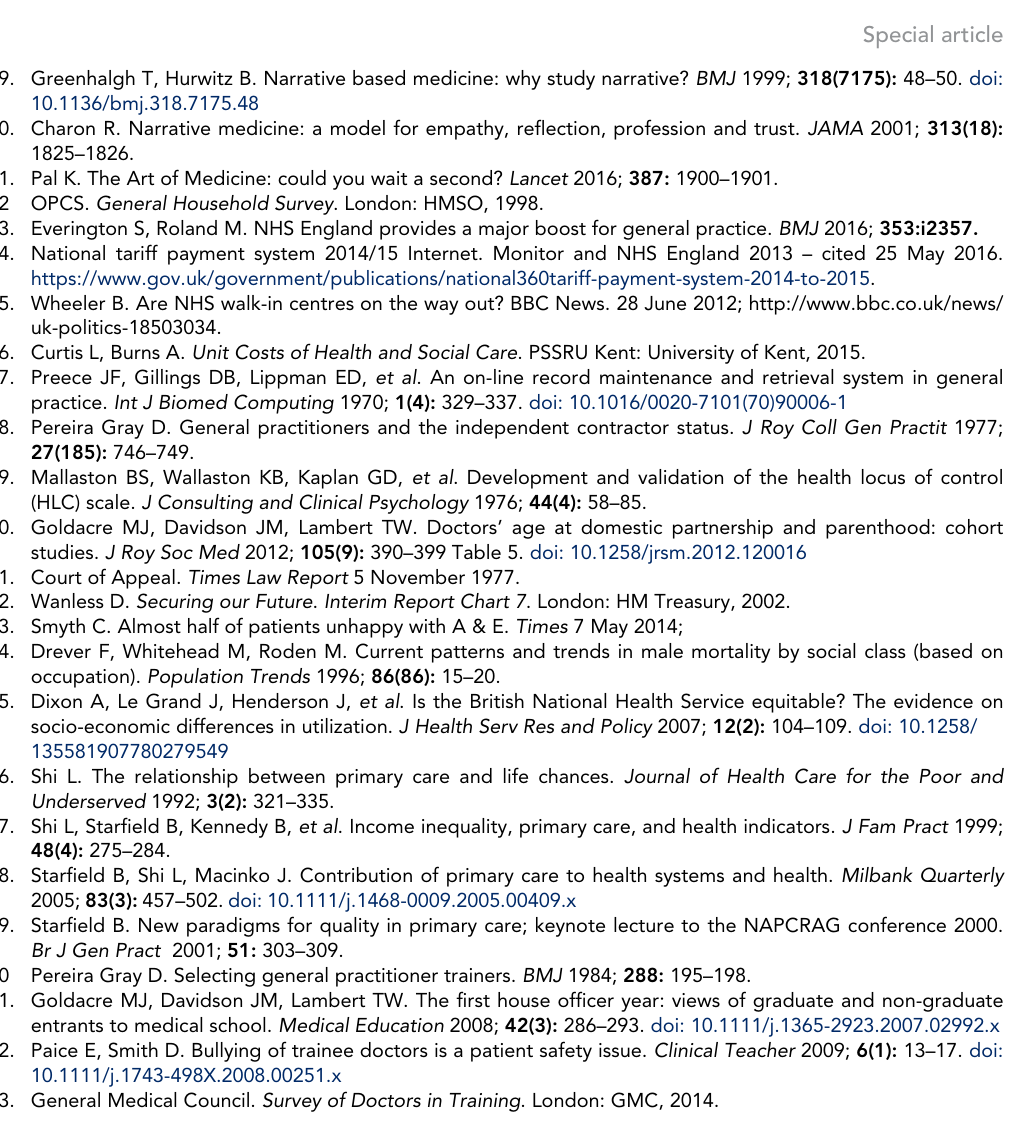
Pereira Gray D. BJGP Open 2017; DOI: 10.3399/bjgpopen17X100569 9 of